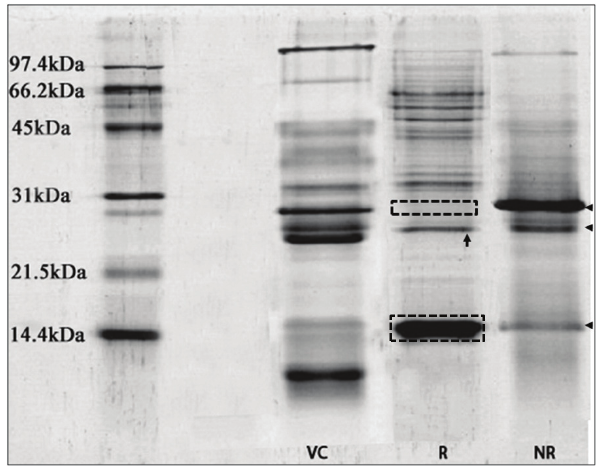
Figure 2. SDS-polyacrylamide gel electrophoresis. VC: whole venom. NR: specific fraction of L.